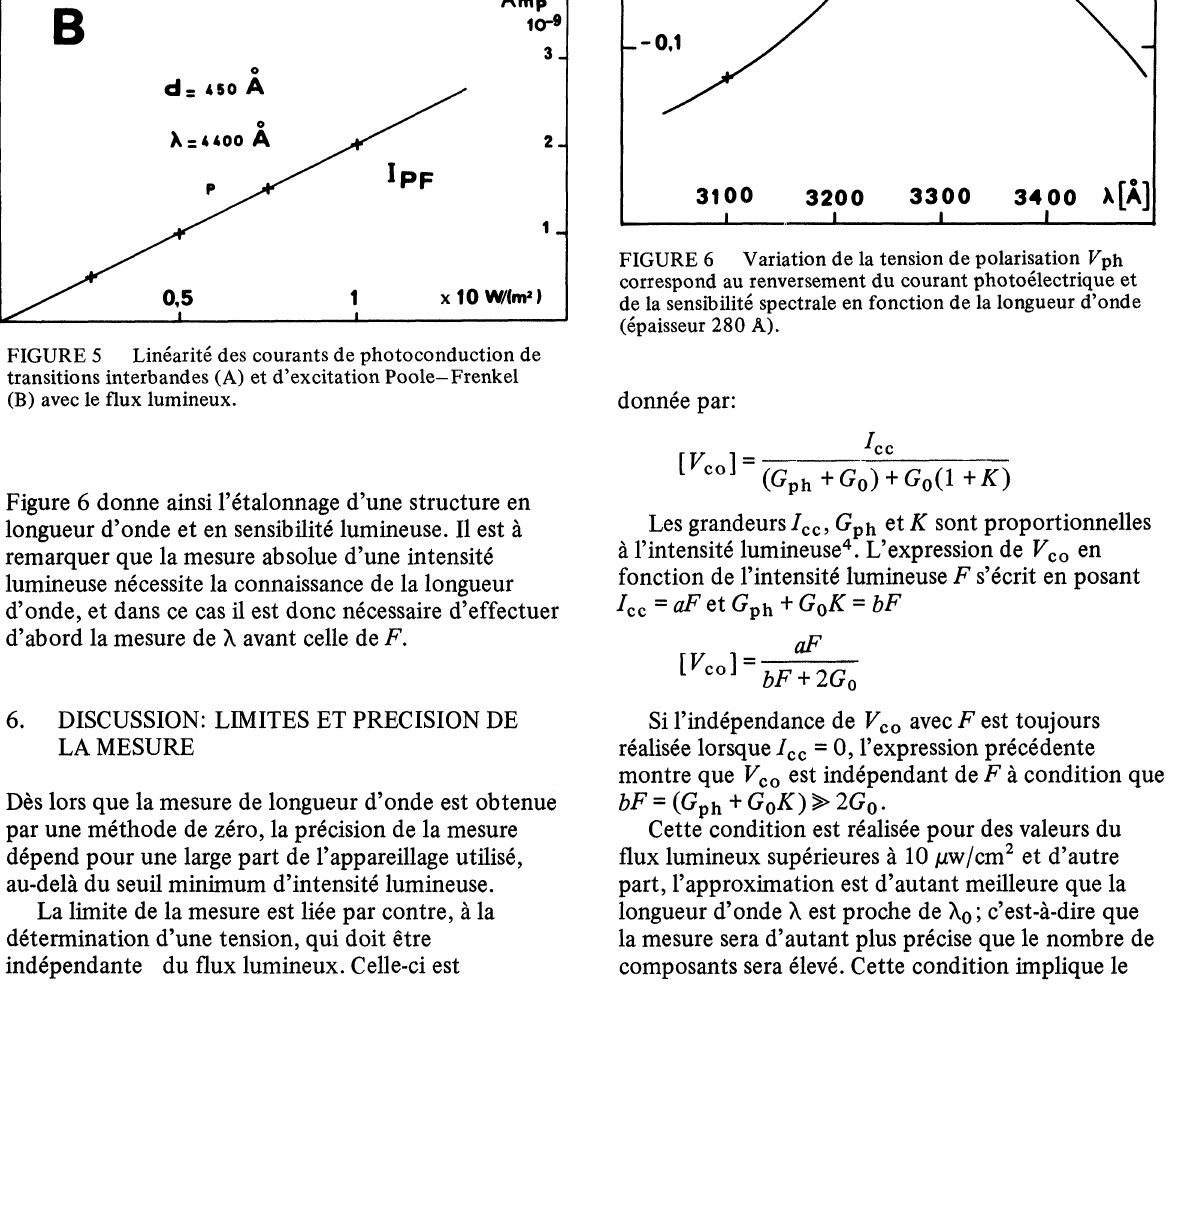
FIGURE 6 Variation de la tension de polarisation Vph correspond au renversement du courant photo61ectrique et de la sensibilit6 spectrale en fonction de la longueur d’onde (6paisseur 280 A). donn6e